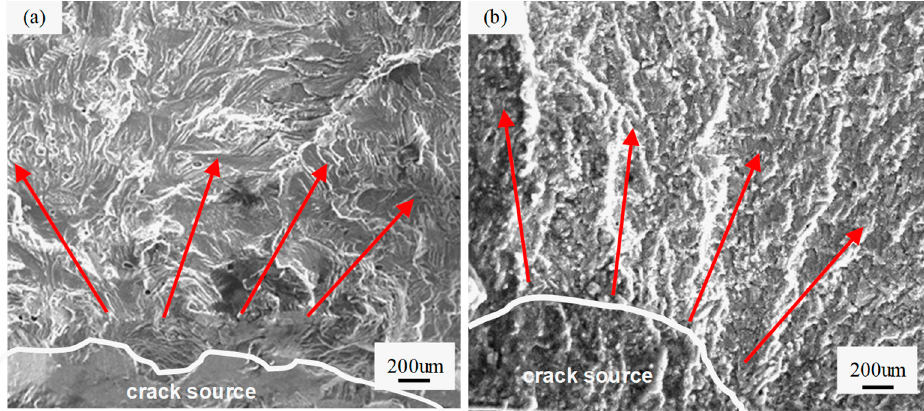
Figure 11. Crack initiation of the ( a ) base material and ( b ) the friction stir crack repaired specimen.